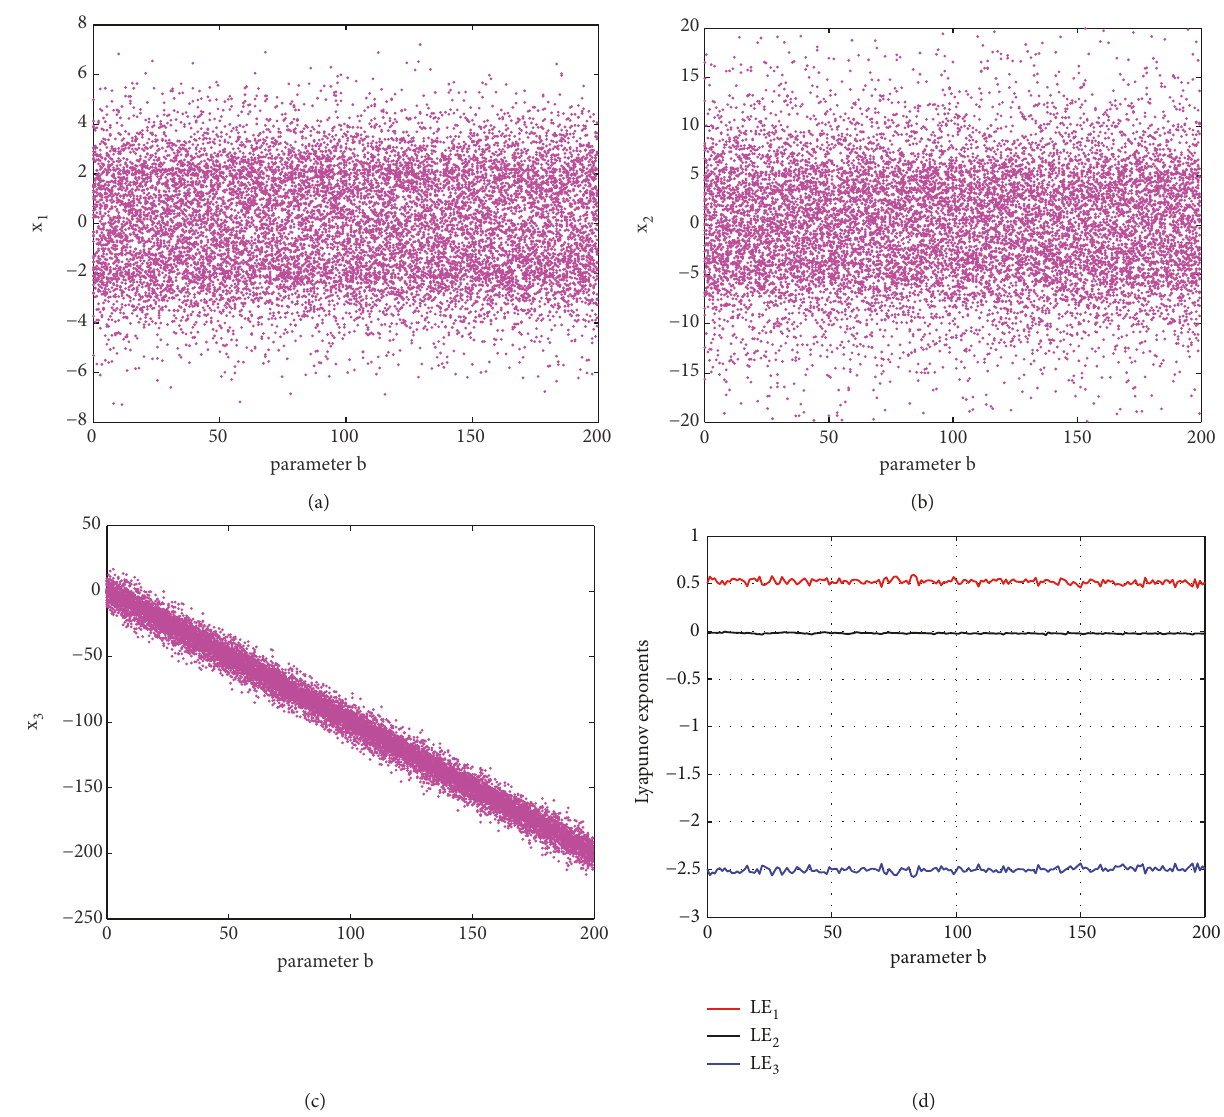
Figure 3: (a), (b), and (c) Bifurcation diagram and (d) Lyapunov exponent spectrum versus parameter b with the parameter set P except for b